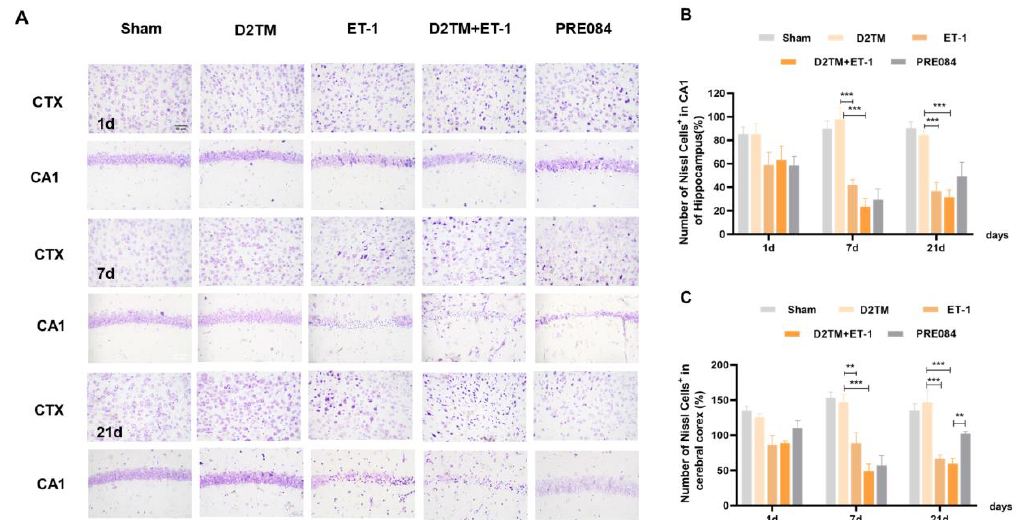
Figure 2. PRE084 attenuated neuronal damage in diabetic mice with stroke. ( A ) Nissl staining of the surviving cells in the hippocampal CA1 region and the cerebral cortex at 1, 7, and 21 d after ET-1 injection. ( B , C ) Quantification of the nissl positive cell number in the hippocampal CA1 region and the cerebral cortex. n = 4 – 5/group. Scale bar = 50 µm. ** p < 0.01, *** p < 0.001.